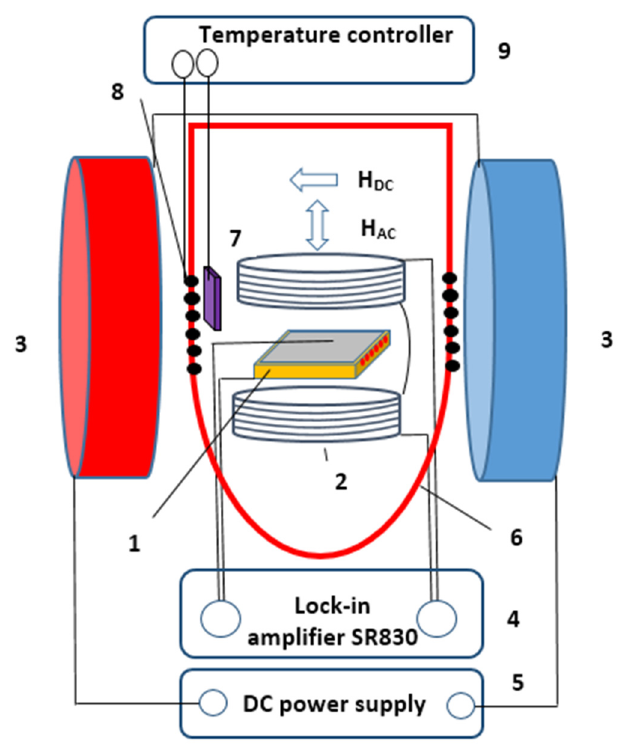
Figure 3. Schematics of the direct ME voltage measurement setup. (1) ME sample, (2) small Helmholtz coils for generating H AC , (3) large Helmholtz coils for generating H DC , (4) lock-in amplifier, (5) DC power supply, and (6)–(9) temperature control units.